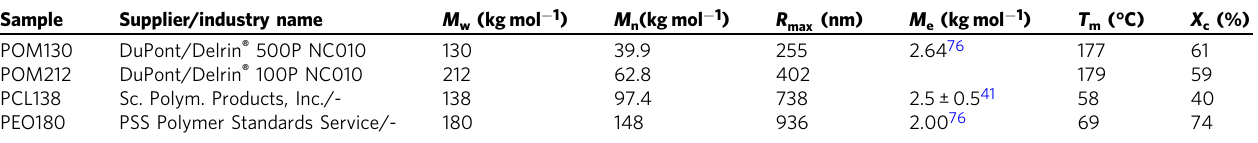
Table 1 Sample characteristics. The molecular weights and therefore also R given in the text. Only for PCL a correction factor of 0.56 is known, which would reduce R temperatures (peak maxima) and crystallinities were obtained by DSC heating scans. The samples were cooled from the melt and heated at a rate of 10 K min (cid:4) 1